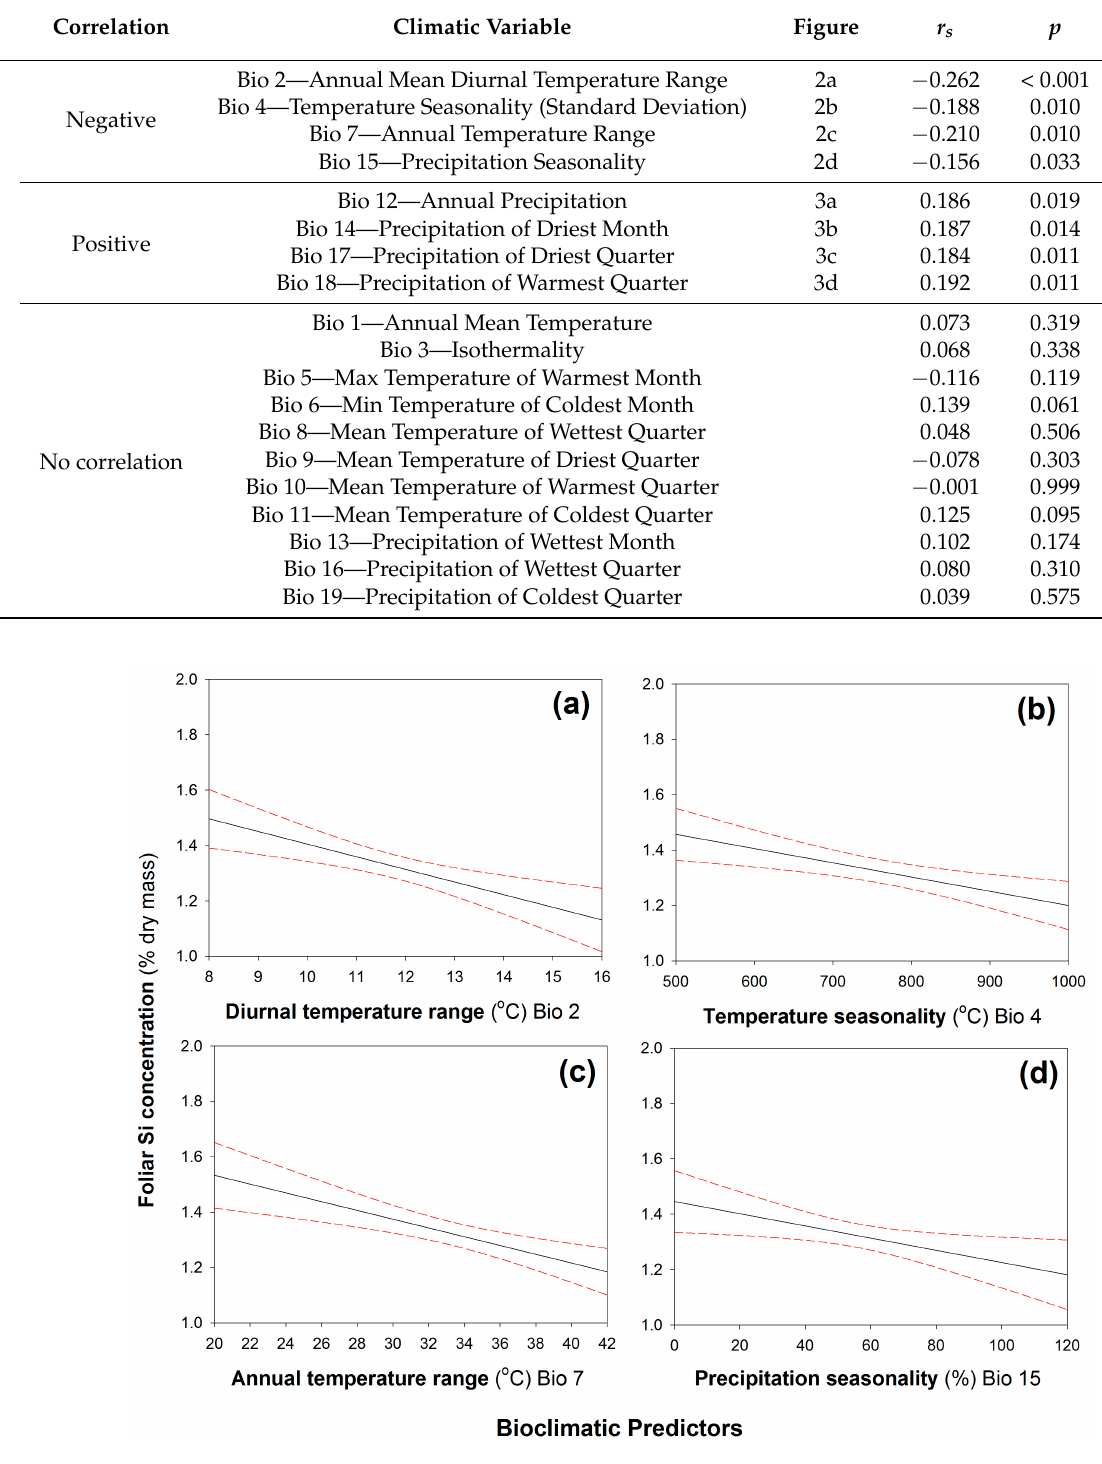
Figure 2. Significant negative correlations between leaf Si concentrations and ( a ) annual mean diurnal temperature range, ( b ) temperature seasonality, ( c ) annual temperature range, and ( d ) precipitation seasonality. N = 247. Regression line (solid line) fitted with 95% confidence displayed as dashed lines. See Table 1 for statistical analysis.